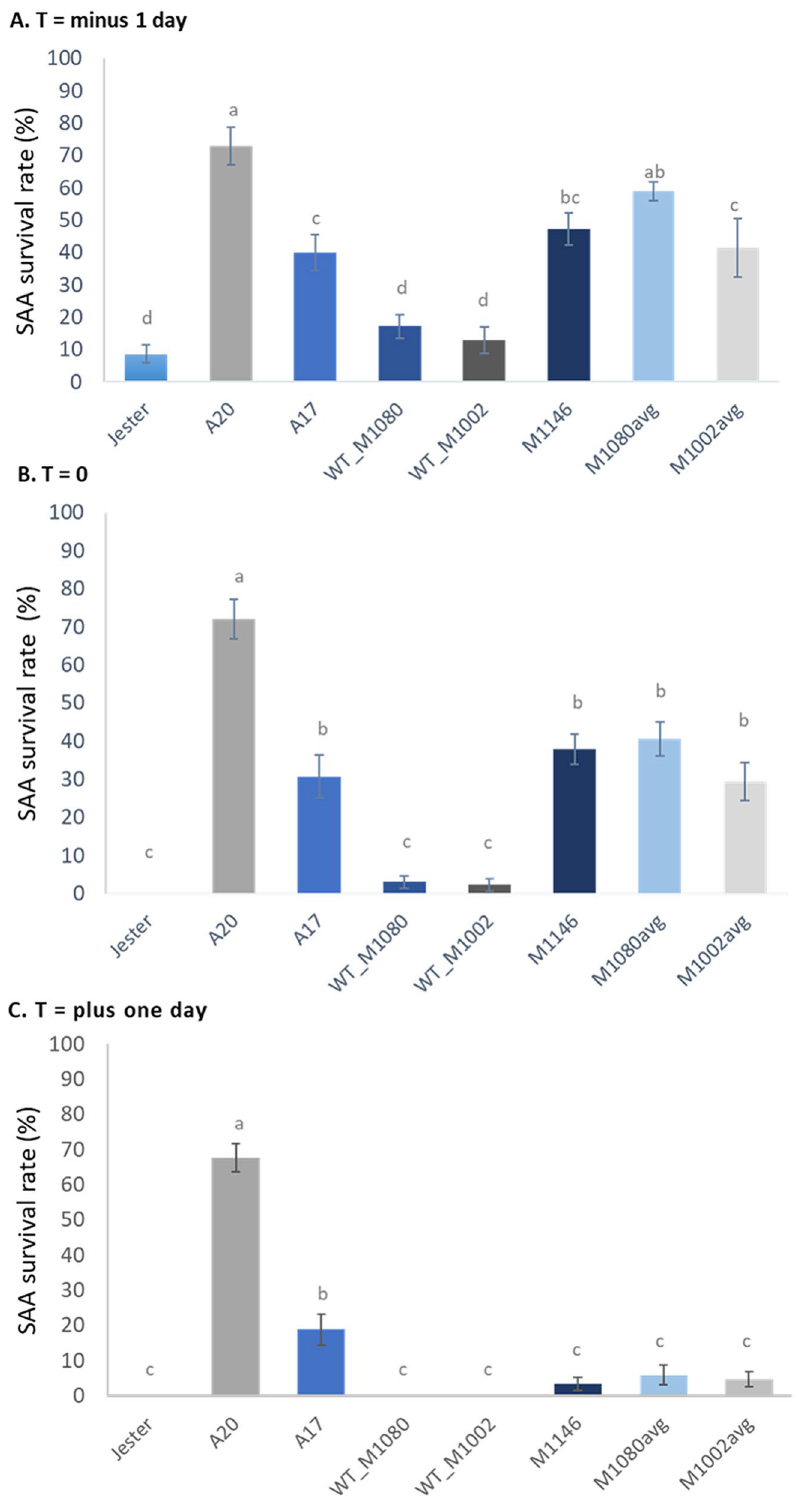
Figure 7. Three truncated TFs cause a delay in SAA mortality compared to their wild-type version in a Jester TILLING background. SAA survival rates were monitored over time and 100% mortality in Jester was set as the null point (T = 0, B ). The homozygous wild-type allele of our target genes in two TILLING lines (WT_M1080 and WT_M1002) is not significantly different to Jester. However, their three independent homozygous STOP lines that were averaged (M1080avg and M1002avg) as well as the M1146 plants are significantly different from Jester (Tukey–Kramer multiple comparison test, P < 0.05) and have increased SAA survival rate at T minus 1 day ( A ) and at T equals 0 ( B ). Although some SAA still survive on the M1146, M1080avg and M1002avg at T plus one day ( C ), this is not significant compared to Jester. Error bars represent standard error and different letters show the significant differences between the samples as determined by Tukey post-hoc